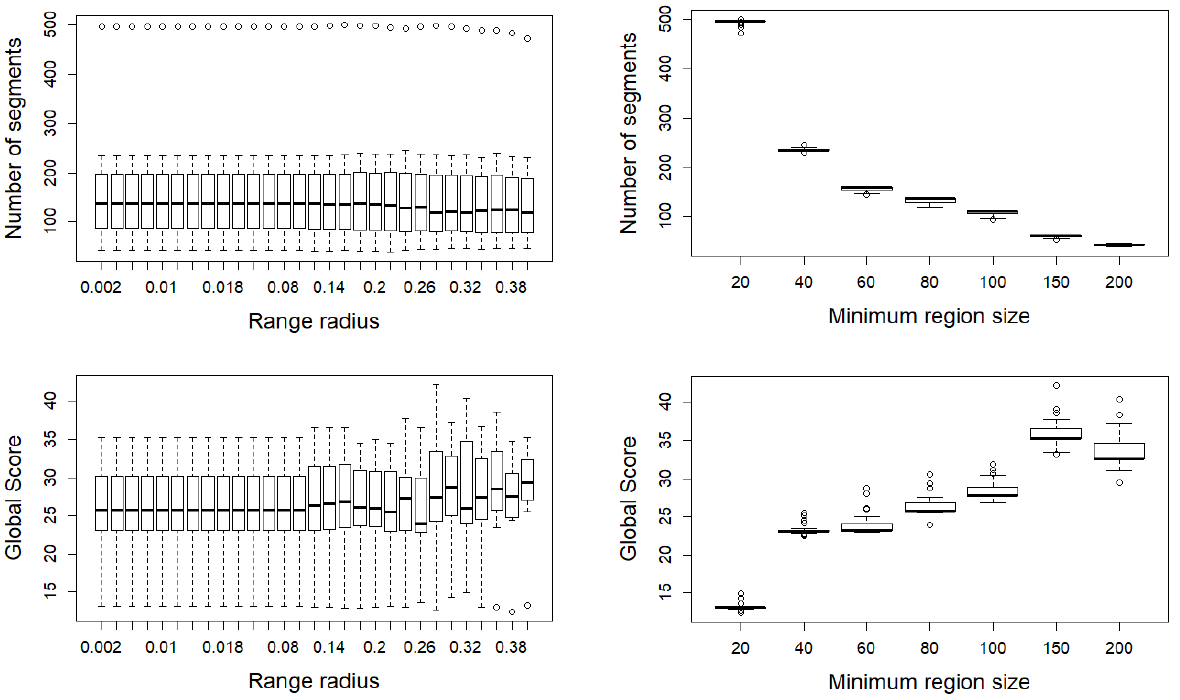
Figure 5. Behavior of the range radius and minimum region size parameters in the validation score of the segmentations and the number of resulting segments.